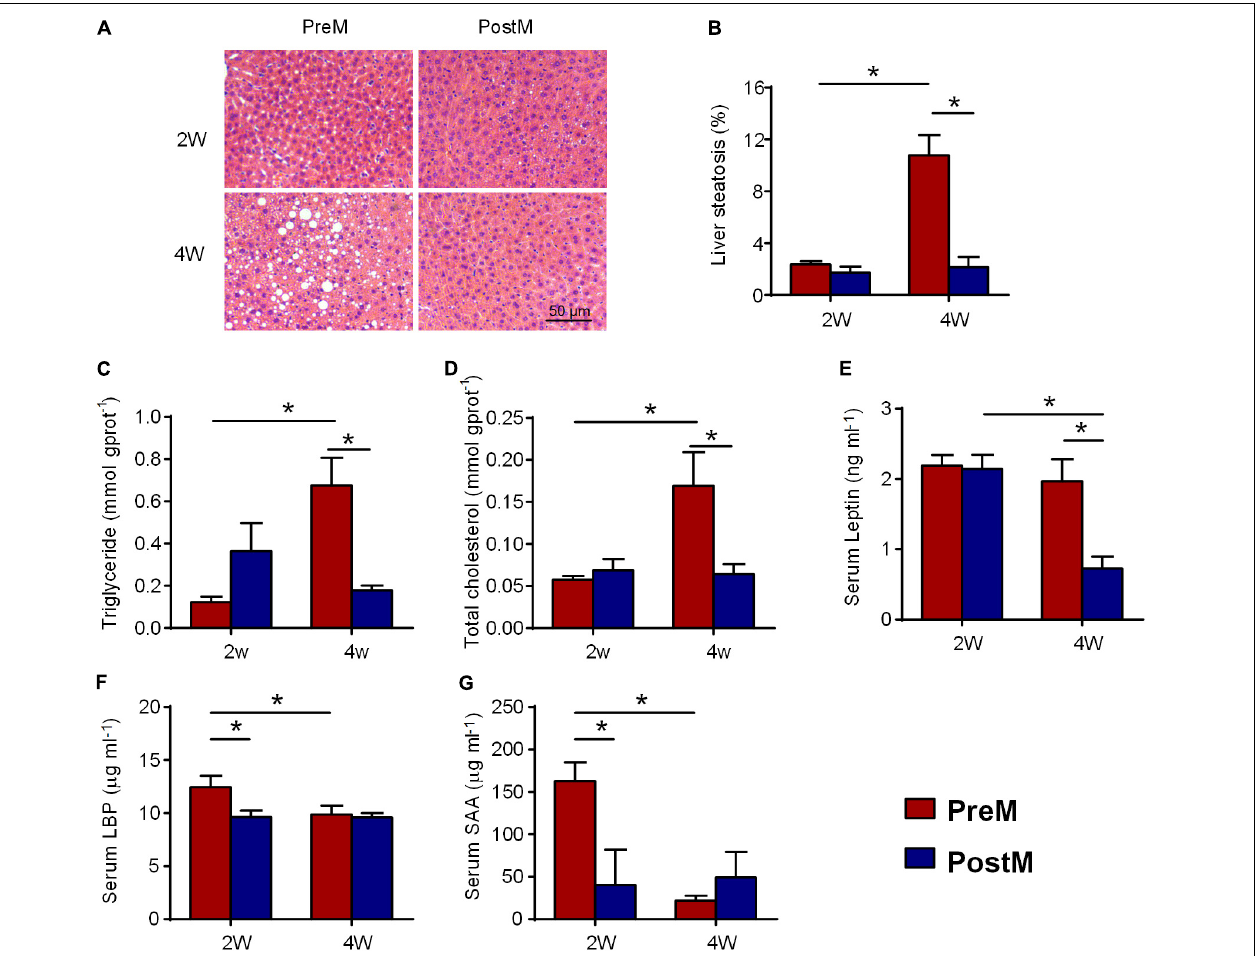
FIGURE 1 | PreM group showed increased lipid concentration and fat accumulation in liver after transplantation for 4 weeks; (A) Representative photomicrographs of hematoxylin- and eosin-stained sections of the liver (100 × magnification); (B) bar graph of the volume density of liver steatosis; (C) hepatic triglyceride; (D) hepatic total cholesterol; (E) serum leptin; (F) serum LBP; and (G) serum SAA levels. Data are shown as the mean ± SEM and were compared between groups and time points using the Mann–Whitney U test; ∗ P < 0.05. n = 4 or 5 for each group. LBP, lipopolysaccharide binding protein; SAA, serum amyloid A